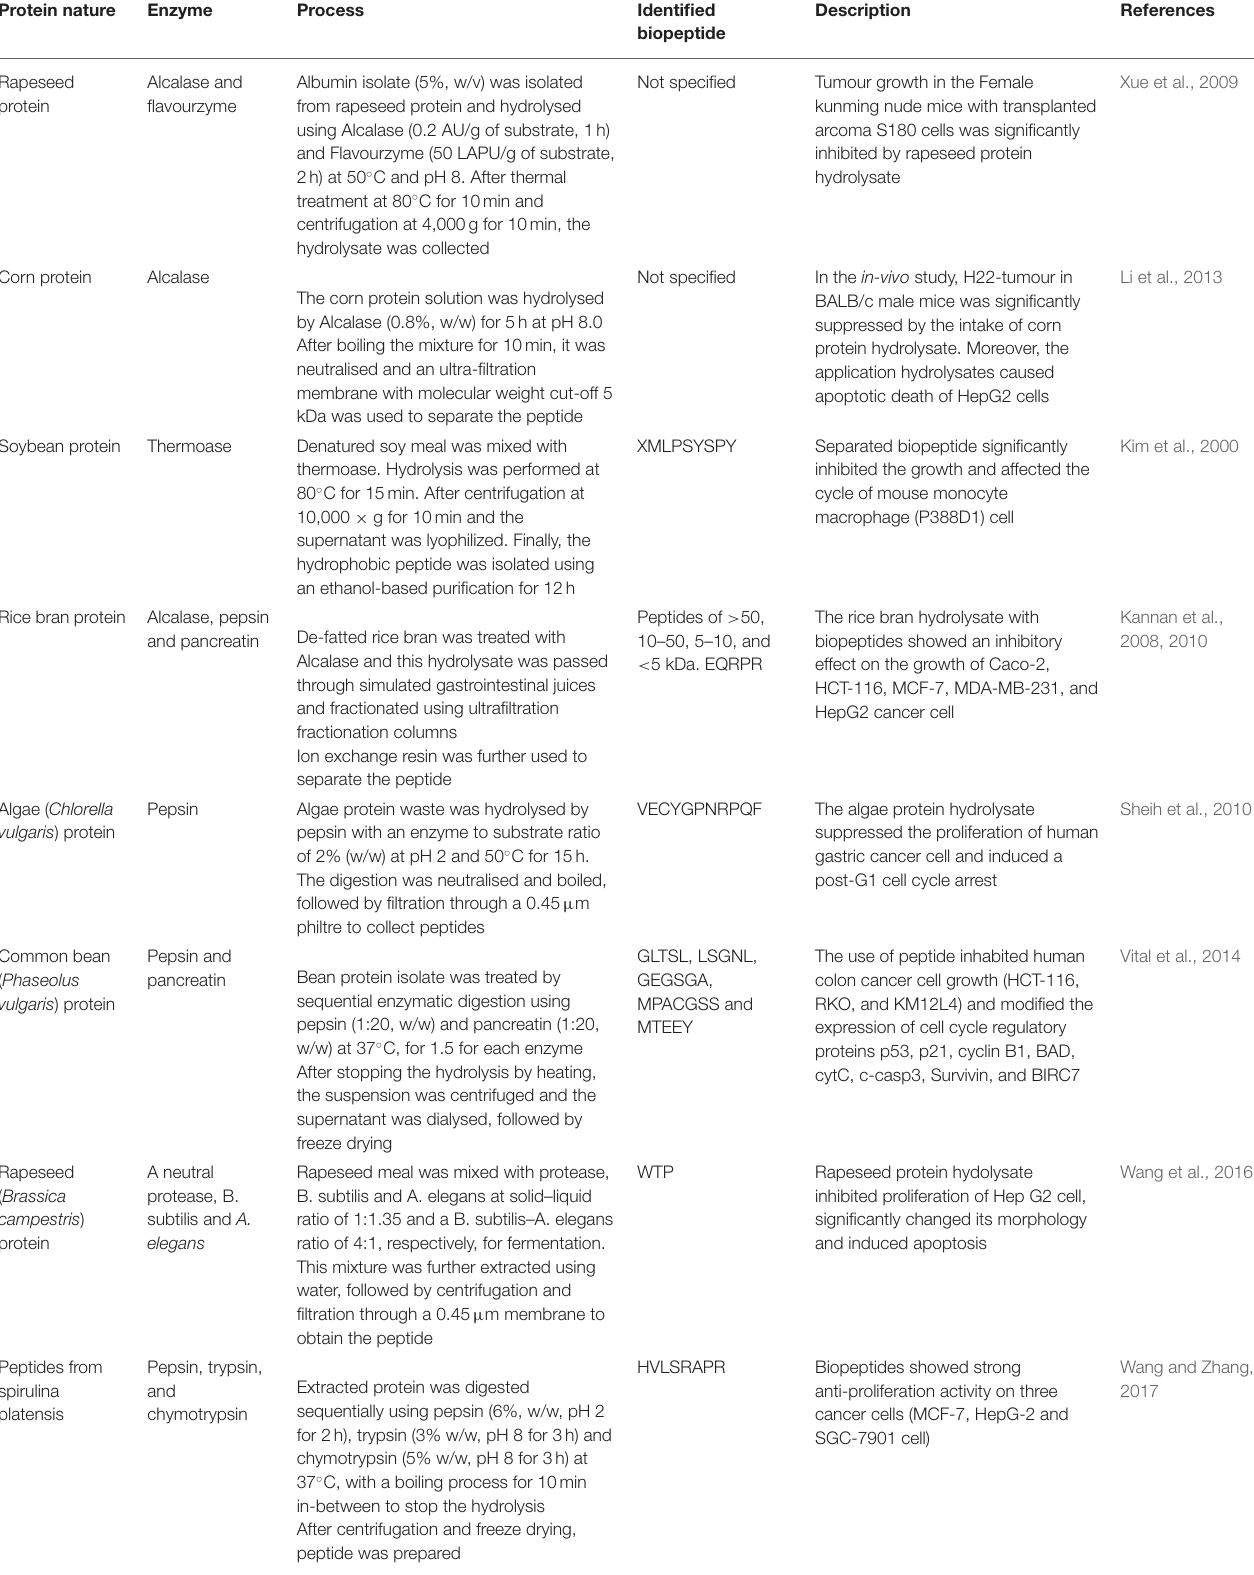
TABLE 3 | Examples of plant-based biopeptides with anticarcinogenic activity. Protein